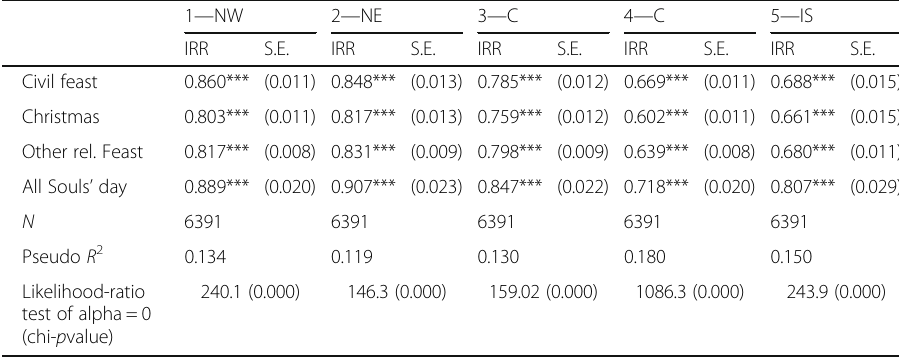
Table 3 The calendar effect on the daily female births in Italian macro-areas from 1 January 1999 to 30 June 2016 (Continued)